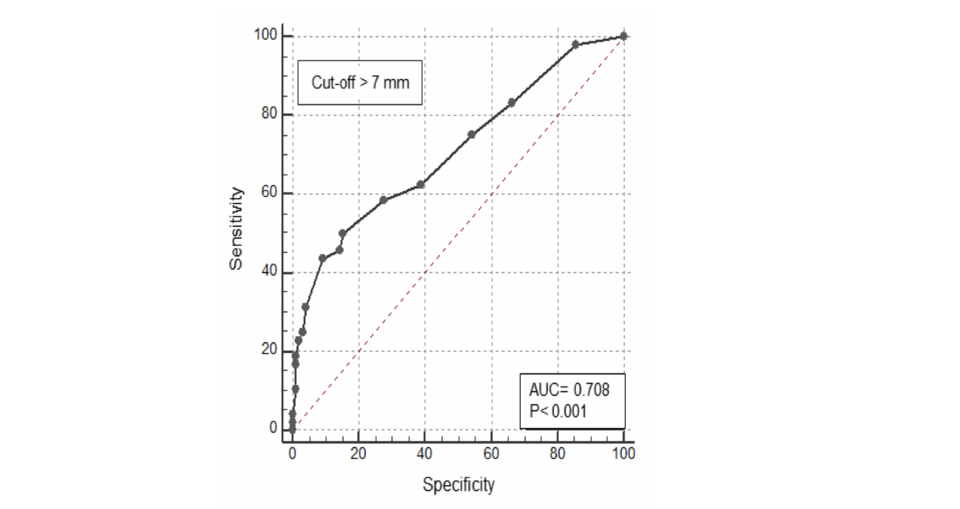
Figure 4. Receiver operating characteristic curve for dysplasia based on the lesion’s size. Table 5. Sensitivity, specificity, PPV, and NPV of single and combined endoscopic features to predict